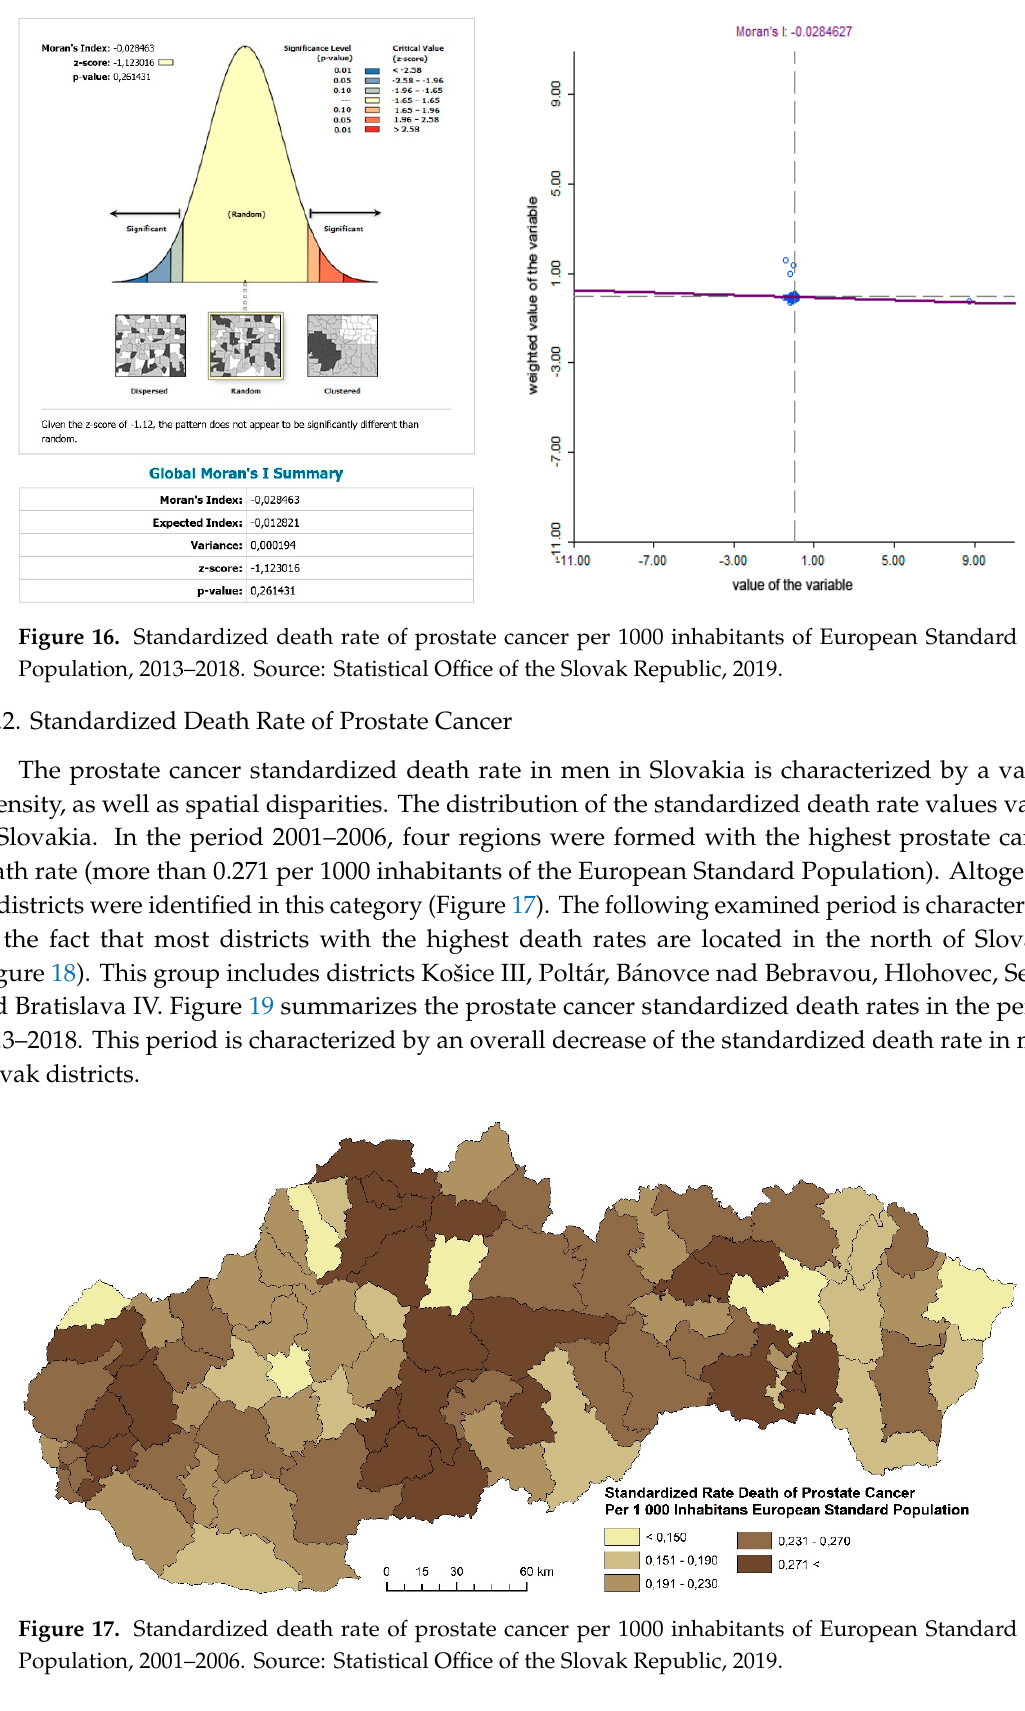
Figure 15. Standardized death rate of prostate cancer per 1000 inhabitants of European Standard Population, 2013–2018.